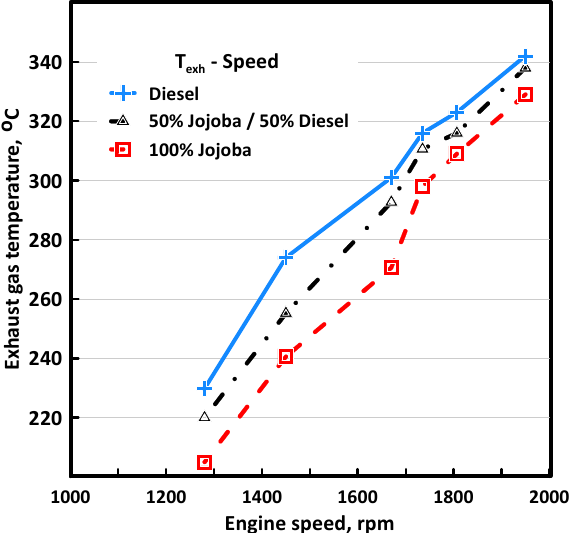
Figure 5. Brake specific fuel consumption of pure diesel fuel, raw Jojoba oil, and 50/50 blend.